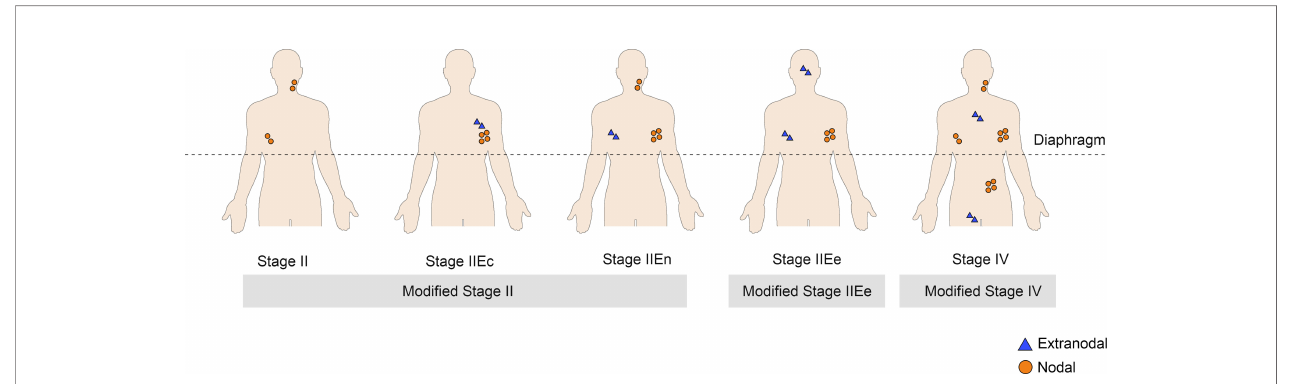
FIGURE 3 | Graphic summarization of the modi fi ed staging